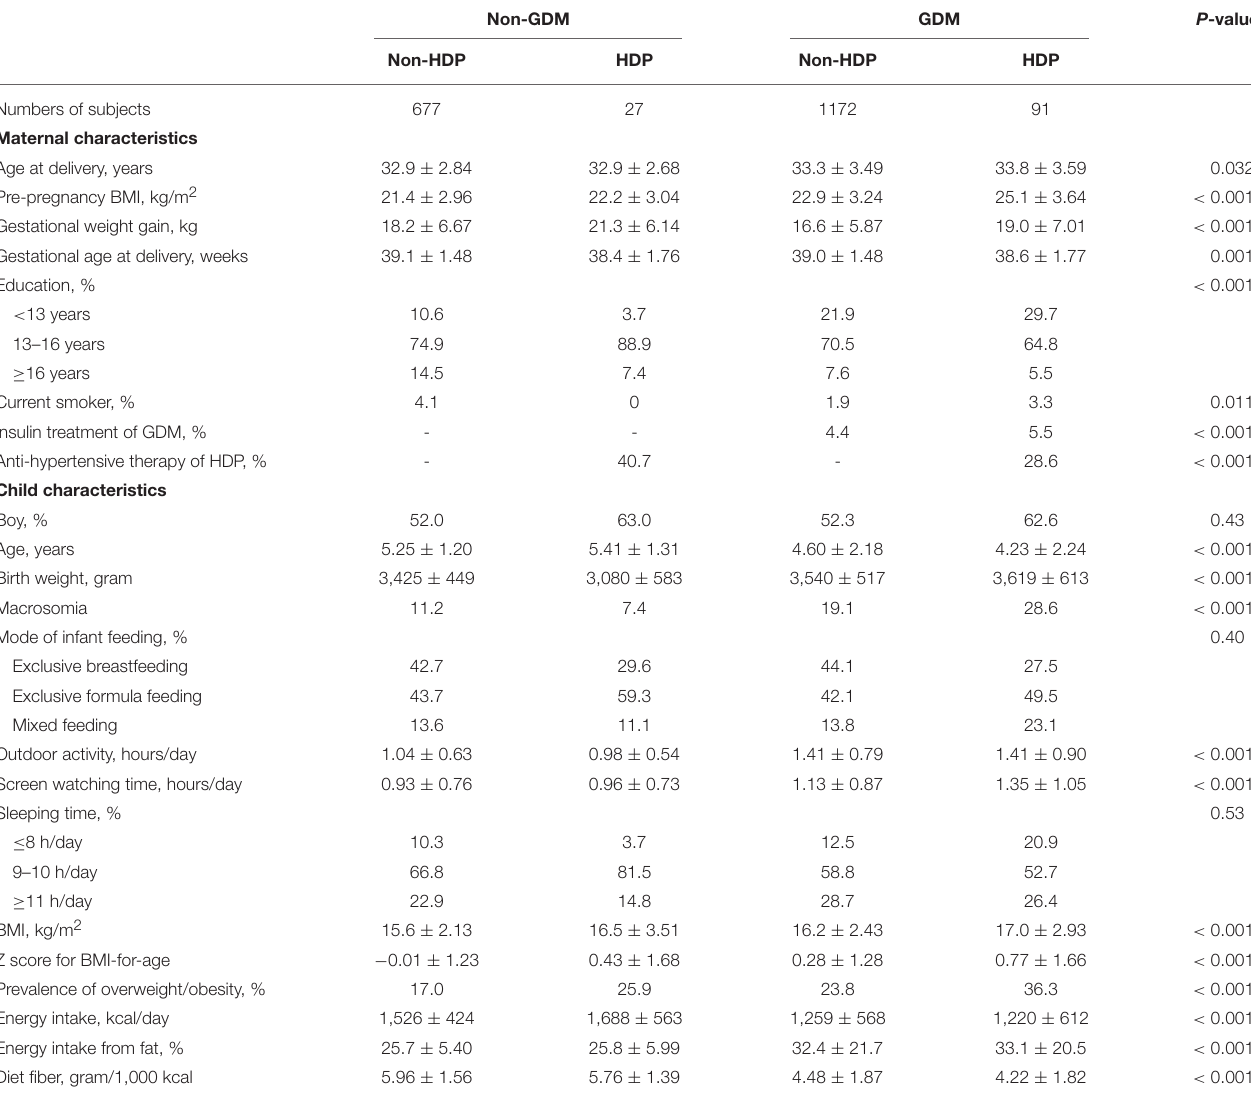
TABLE 1 | Maternal and child characteristics according to maternal gestational diabetes and hypertensive disorders of